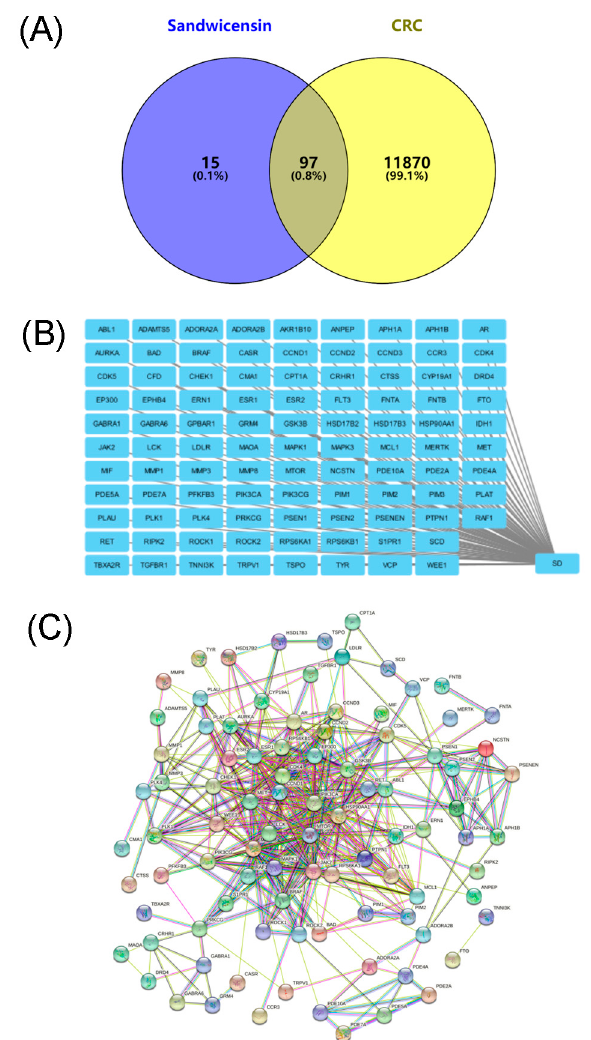
Figure 4. Network pharmacology analysis. ( A ) Venn diagram; ( B ) network of the treatment of CRC with Sandwicensin; ( C ) PPI network analysis. Nodes represent target proteins and edges represent interactions between target